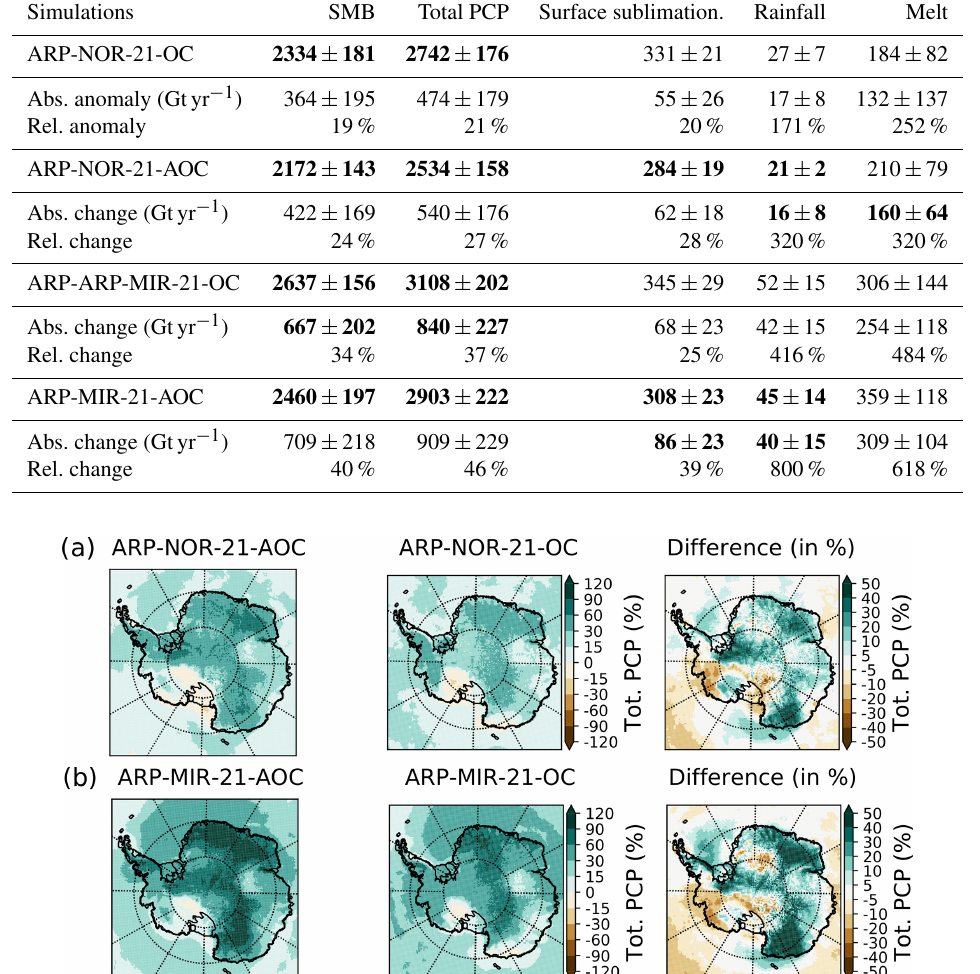
Table 7. Absolute values and absolute (Abs.) and relative (Rel.) anomalies for mean SMB and its components (Gtyr − 1 ) for the Antarctic GIS in the different ARPEGE RCP8.5 projections (reference period: 1981–2019). Anomalies and absolute values significantly different ( p < 0 . 05) in projections realized with bias-corrected atmosphere with respect to control run are displayed in bold. Surface sublimation. Rainfall